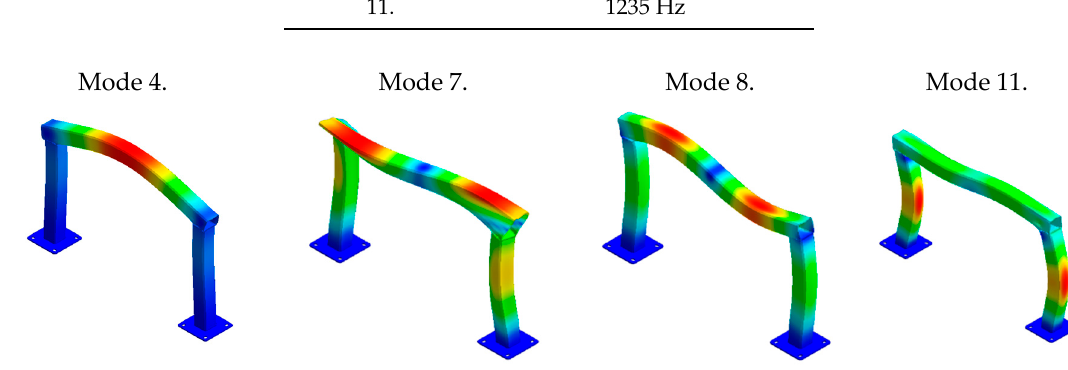
Figure 10. Geometric model ( a ) and discrete model ( b ) of the steel frame under consideration.